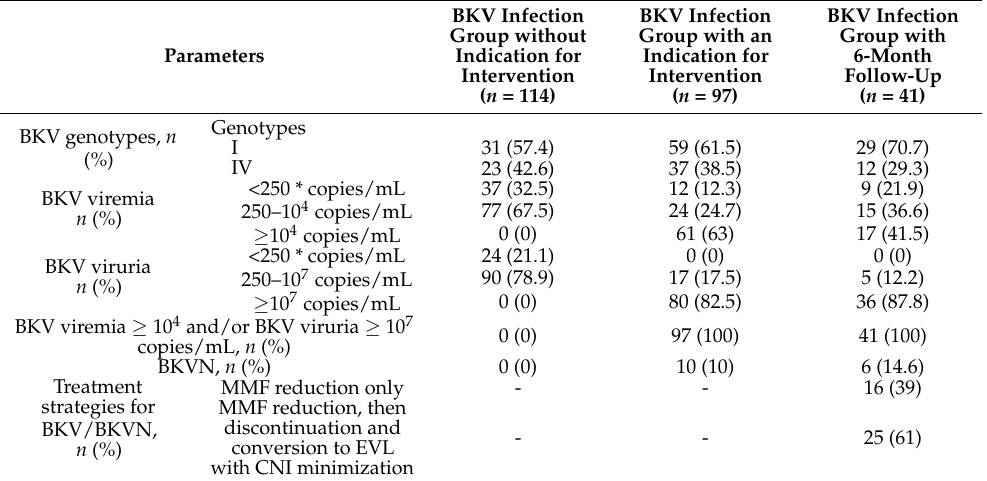
BKV Infection Group without Indication for Intervention ( n = 114)